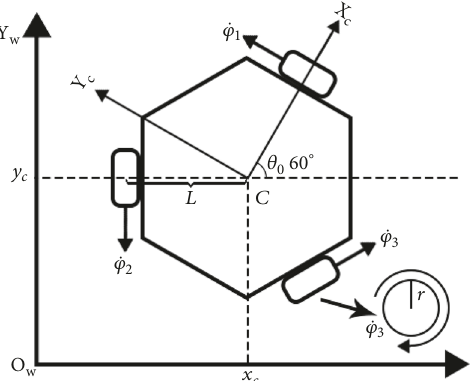
Figure 2: Geometrical modeling of the mobile